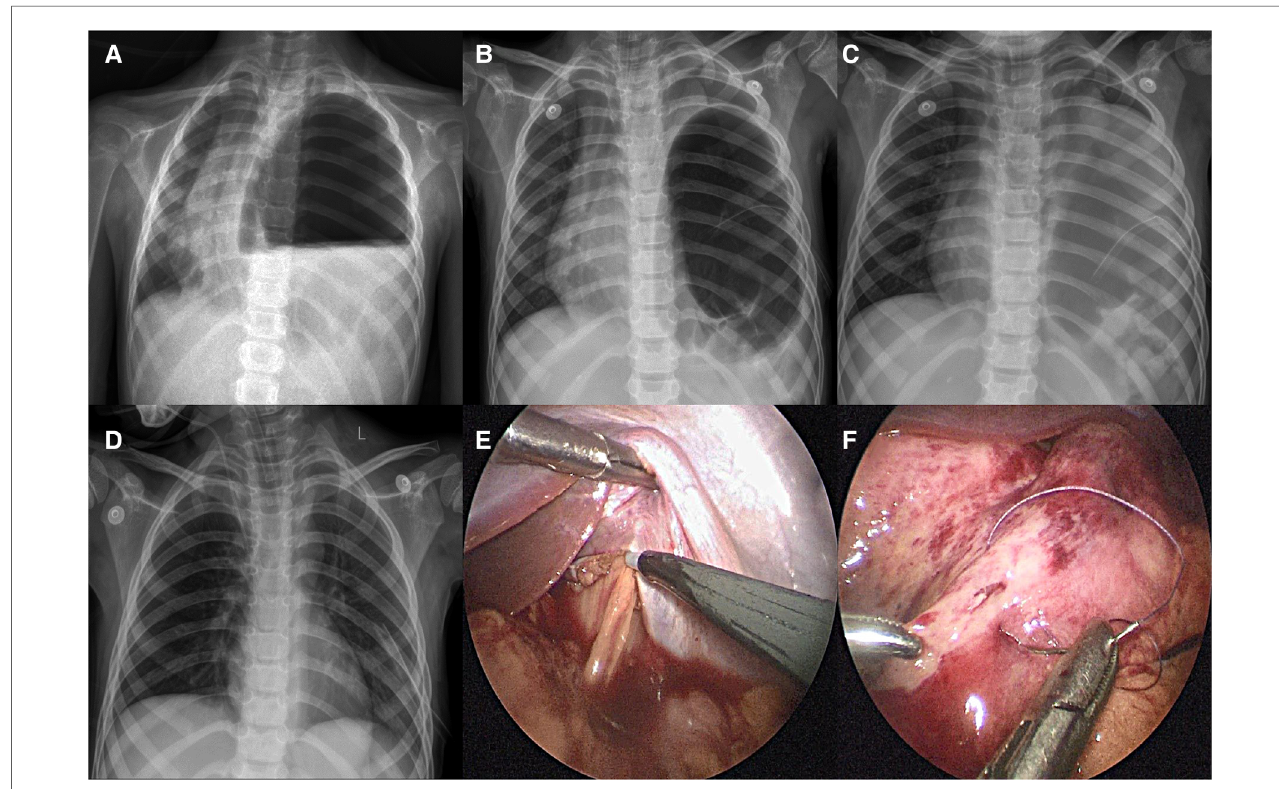
FIGURE 1 Case 1: preoperative and postoperative x-ray fi ndings and intraoperative conditions: ( A ) encapsulated gas accumulation with mediastinal displacement; ( B ) encapsulated gas accumulation still exists after re-placing the thoracic drainage tube; ( C ) after adjusting the thoracic drainage tube, the wrapped gas accumulation disappeared, but the left costophrenic angle was vague, indicating the presence of pleural effusion; ( D ) after the operation, the diaphragm recovered to normal position and the lung expanded well; ( E ) hemorrhagic effusion in the abdominal cavity, obvious gastric edema and expansion, and enlarged diaphragm incision; ( F ) repair iatrogenic gastric